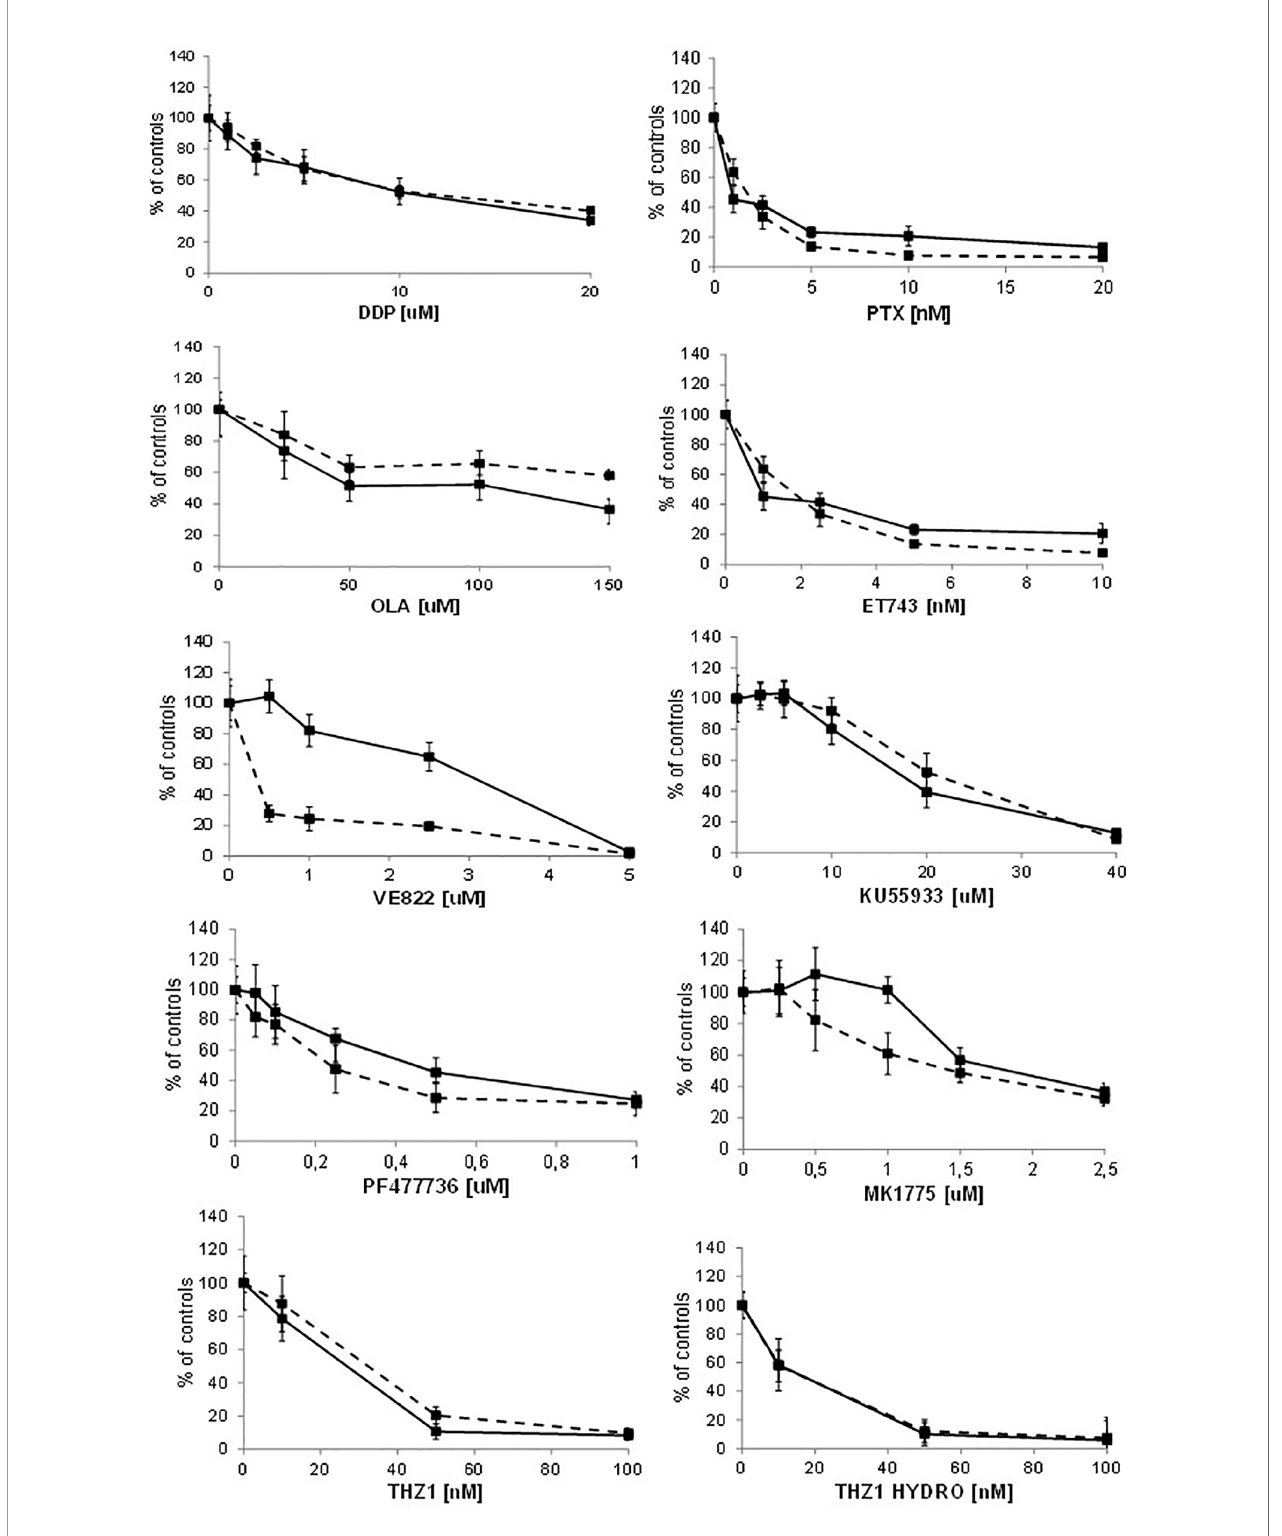
FIGURE 5 | Drug dose-response curves. Dose-response curves of A2780 - - - ■ - - - and A2780 KO ▬▬■▬▬ to cisplatin, paclitaxel, olaparib, ET-743, VE822, KU55933, PF477736, MK1775, THZ1, THZ1 hydrocloride. Data are expressed as survival percentages over controls (+ standard error) of least three experiments done in